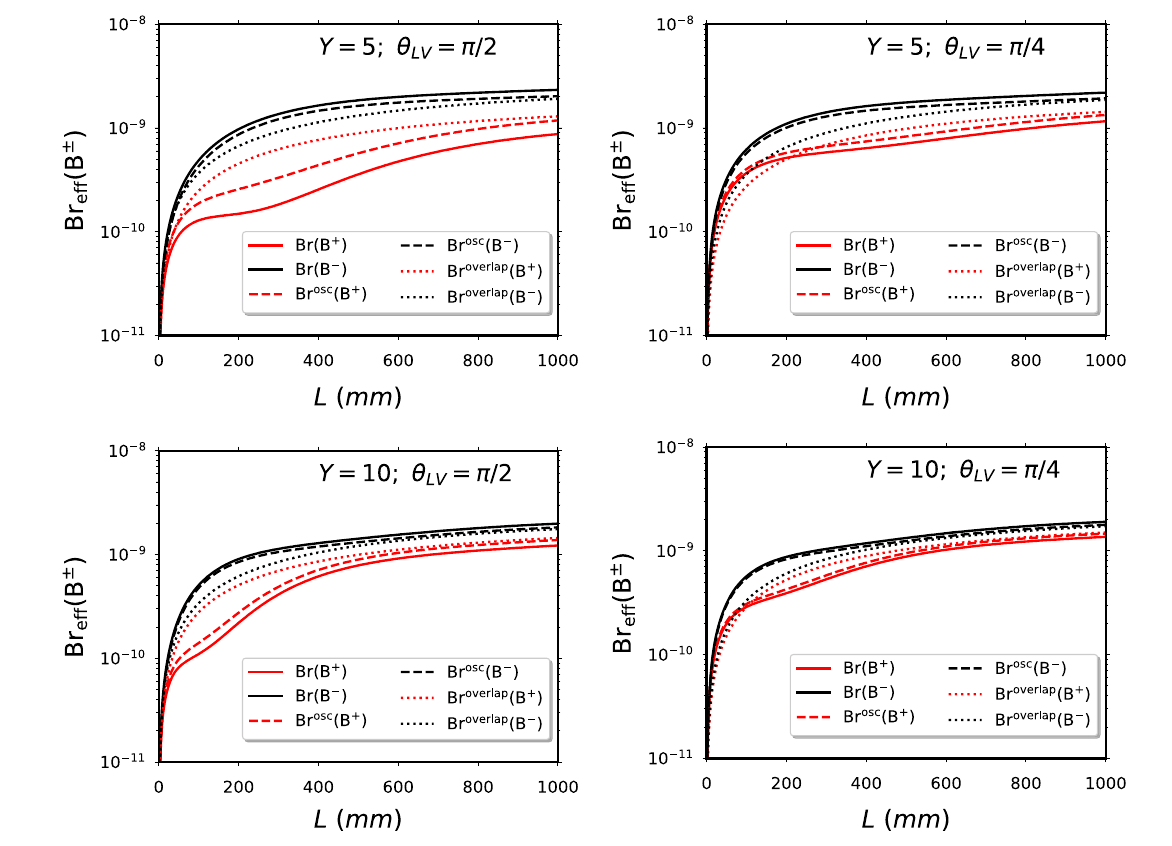
Fig. 3 Different contributions to the total effective branching ratio as a function of the maximal displaced vertex length ( L ) for M N = 2 . 0 GeV , | B μ N | 2 = | B τ N | 2 = 10 − 5 and different values of Y and θ LV .